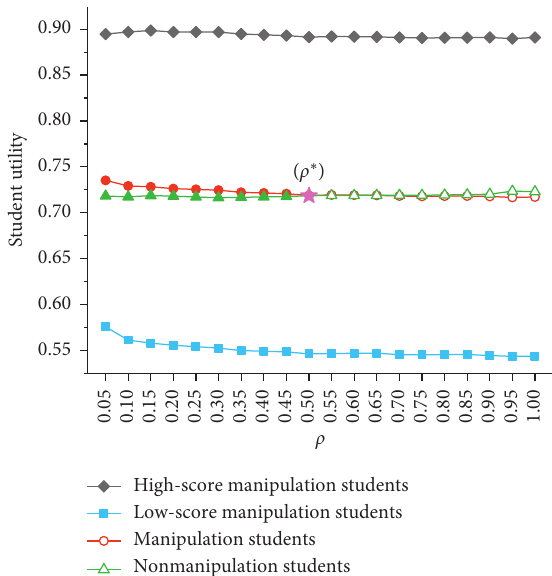
Figure 2: Relationship of manipulation-seeking ratio ( ρ ) and the utilities of different students. The utilities of students are calculated with the optimal seat-transfer time of manipulation students. The steady state ( ρ ∗ ) is marked with